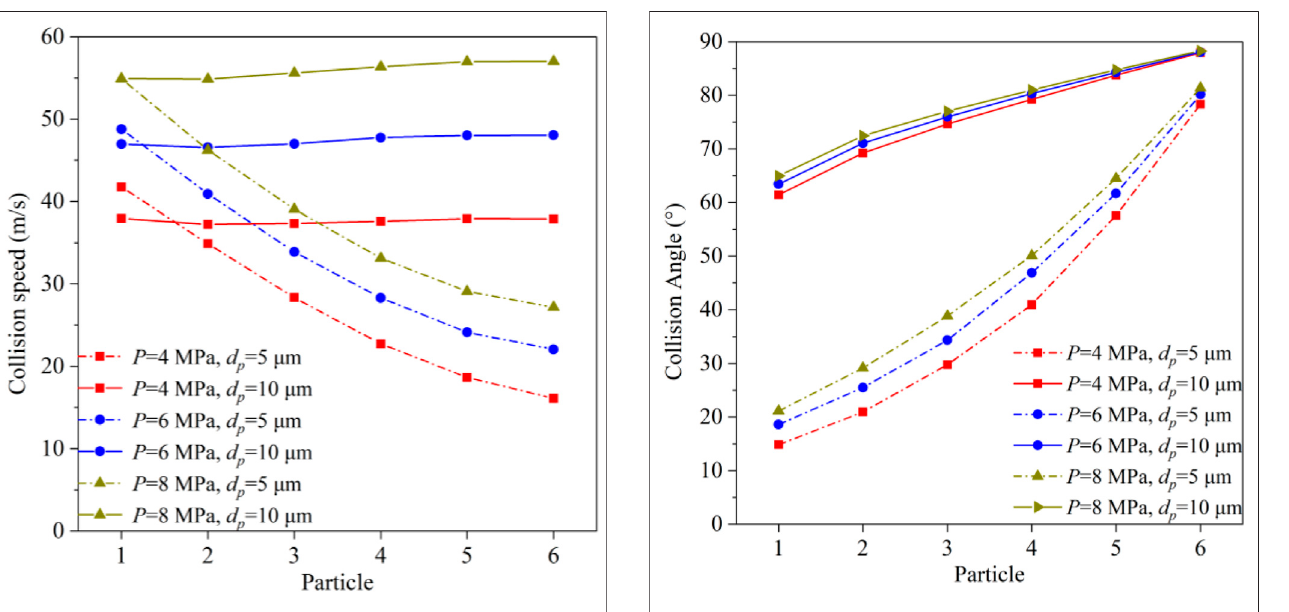
FIGURE 7 | Collision speed of abrasive particles of two sizes. FIGURE 8 | Collision angle of abrasive particles of two